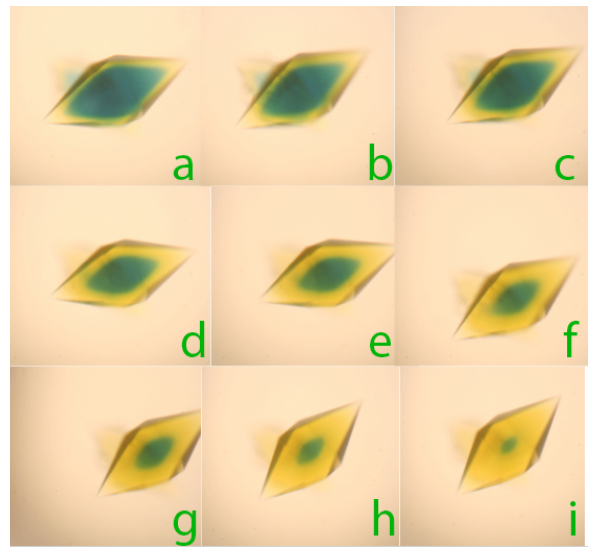
Figure 2. A tetragonal crystal of thaumatin about 1 mm in length was stained to saturation over 48 h with the pH sensitive dye bromophenol blue. The crystal was initially at pH 8.25 so that its color was blue–green. The mother liquor was then removed and replaced with an equivalent mother liquor but at pH 6.5. As H 3 O + ions diffused into the crystal, the incorporated bromophenol blue dye transformed chemically and yielded a yellow color. The change of color shows a clear leading edge and the rate of penetration of the yellow color provides a measure of the diffusion of H 3 O + ions into the crystal. The total time required for complete color transformation was about 30 to 40 min. The series of images ( a – i ), taken at appropriate time intervals, shows the progress of the dye.